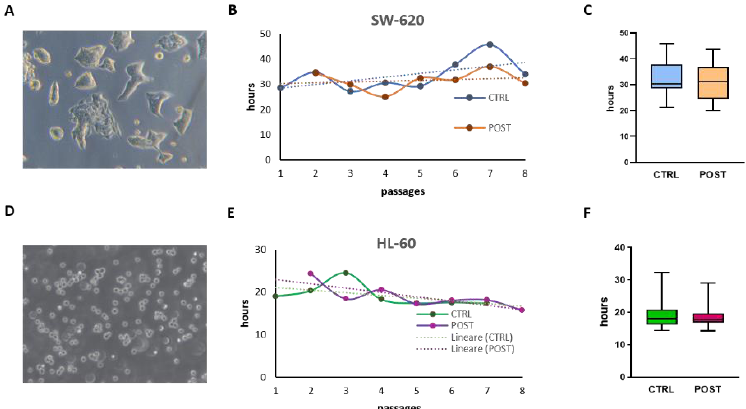
Figure 5. Representative image of SW620 cells in culture growing in colonies ( A ), and HL60 cells growing in suspension ( D ). The doubling time (DT) for both cell lines was monitored during passages in culture, and the line of tendency represents the average ( B , E ). The mean DTs for both cell lines in all passages analyzed are represented by scatter plot graphs for the CTRL- and POST-derived cells ( C , F ).